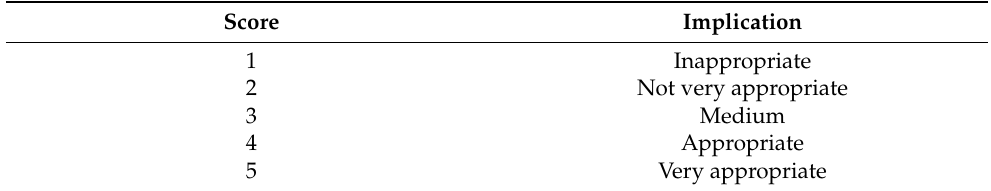
Table 5. The implication of photo